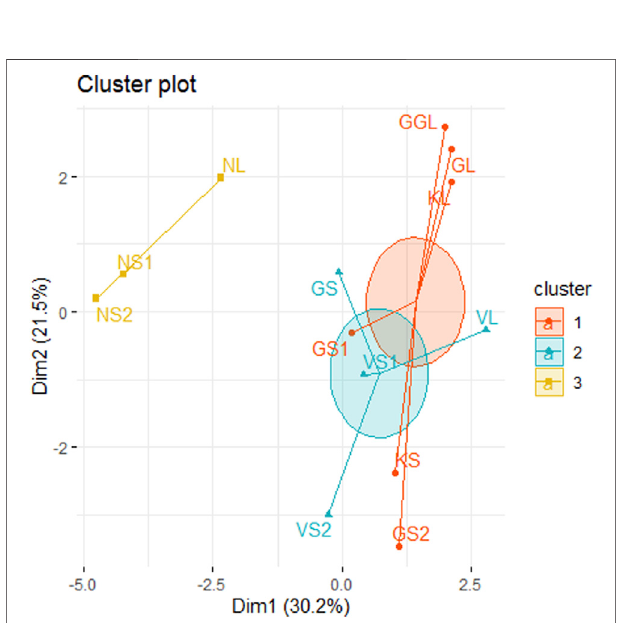
FIGURE 5 | Cluster validation using Silhouette coef fi cient measures highlighting three cluster and placement of sites in their right